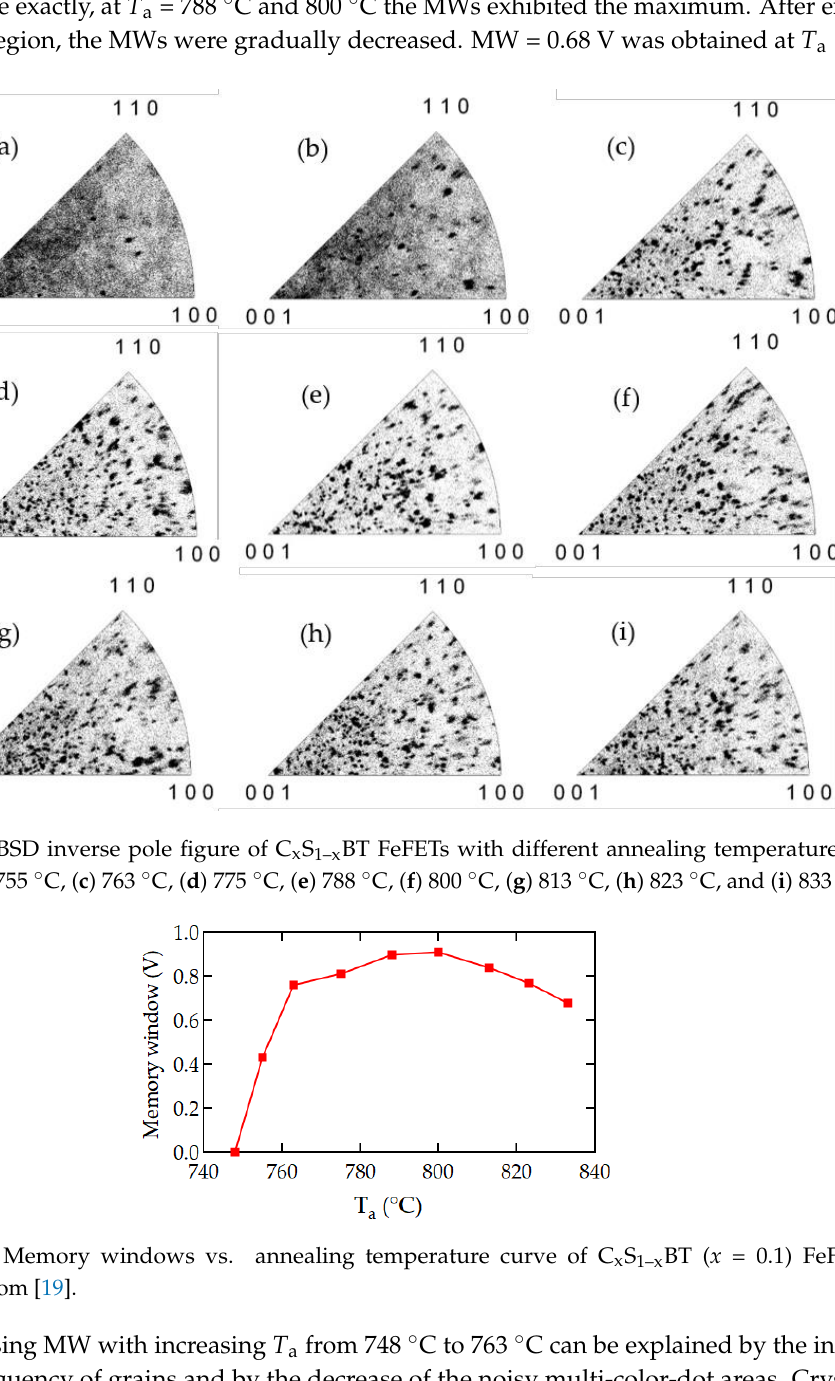
Figure 10. Memory windows vs annealing temperature curve of C x S 1 – x BT( x = 0.1) FeFETs. Modified from [19]. 4. Conclusions